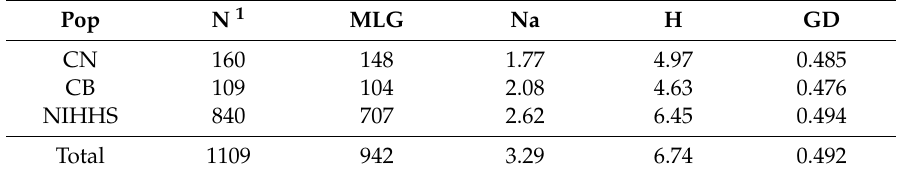
Table 2. Summary of cluster diversity indices averaged over 17 loci according to conservation institutes.